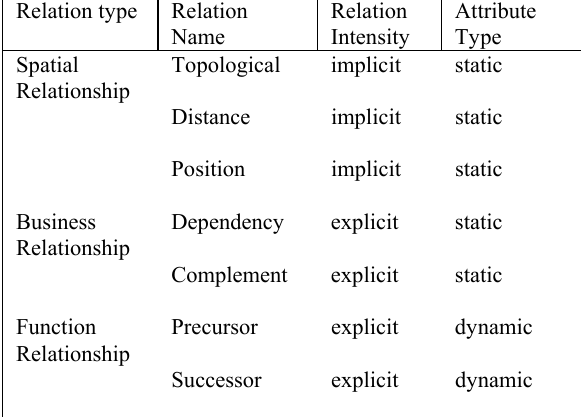
Table 1. Relationships of GI